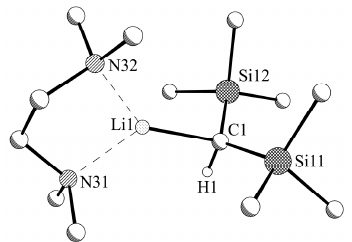
Figure 4. Molecular structure of LiCH(SiMe 3 ) 2 -TMEDA, 1b ; only one of the two independent molecules in the asymmetric unit is shown. Selected hydrogen atoms and disordered units of minor occupancy are omitted for clarity.